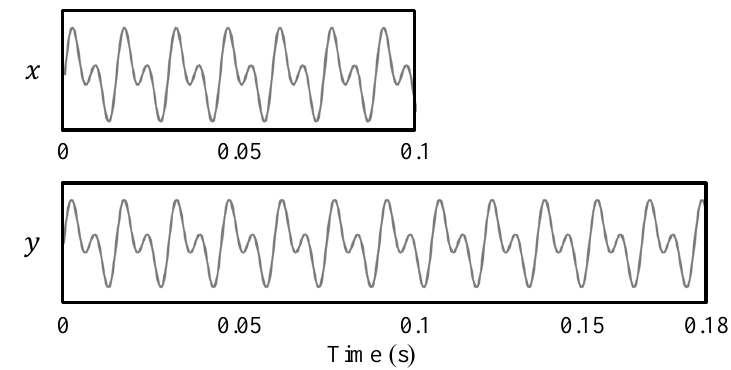
Figure 6. Preservation of periodic structures by WSOLA. The input signal x is the same as in Figure 4, this time modified with WSOLA (time-stretch with α = 1.8).